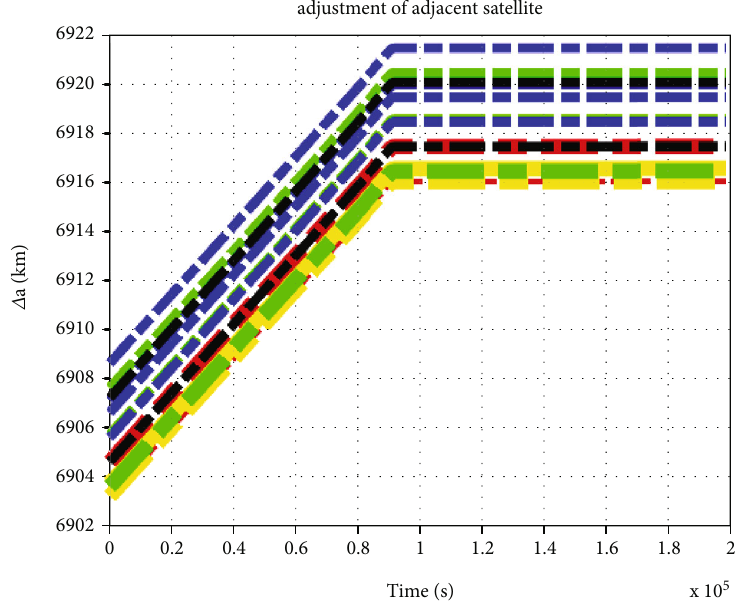
Figure 13: Schematic diagram of constellation initial phase deployment